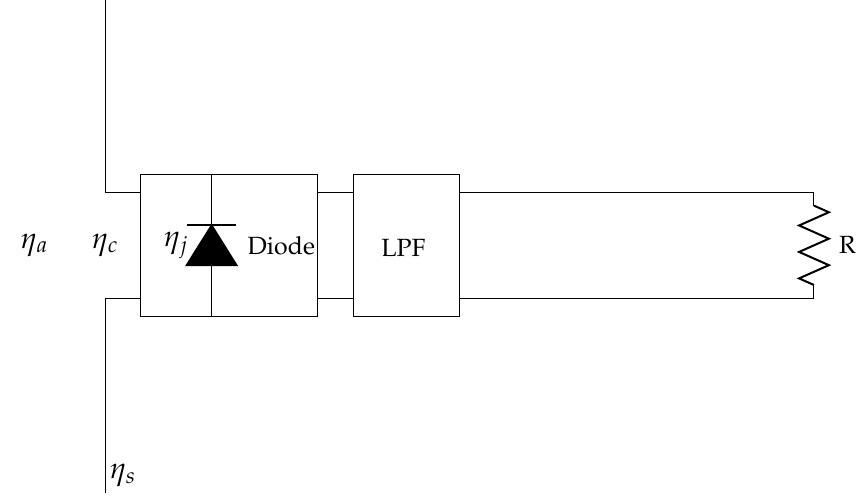
Figure 2. Generic circuit diagram for a rectenna system (Adapted with permission from [16], Springer,